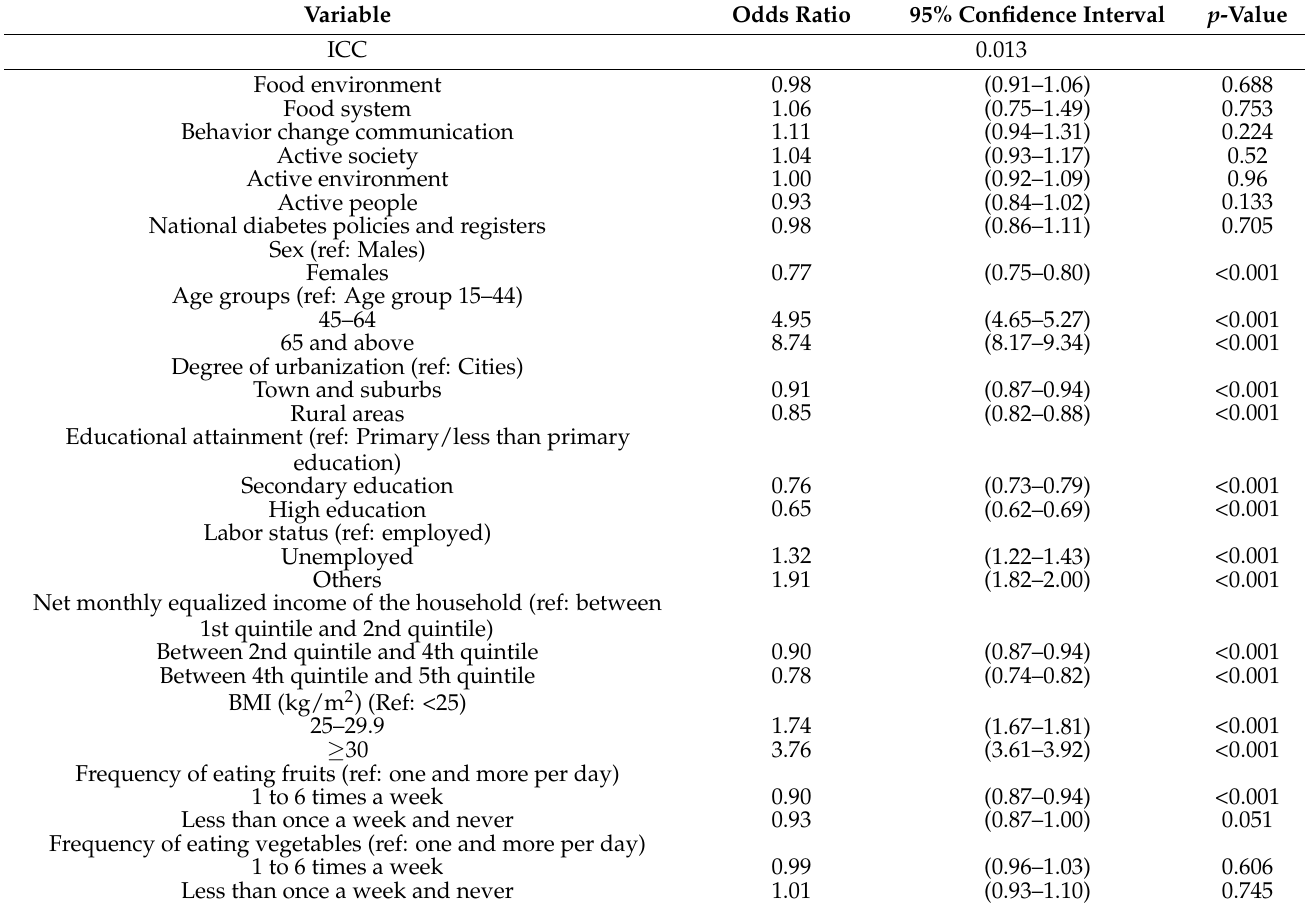
Table 4. Association of diabetes mellitus and demographic, socioeconomic, lifestyle and number of policy